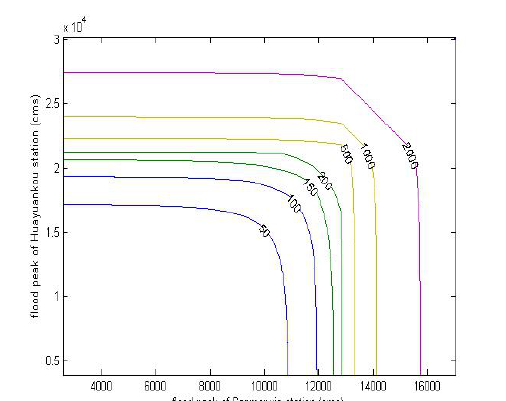
Fig. 10. isoline of concurrent return periods between the annual maximum flood magnitudes of Sanmenxia